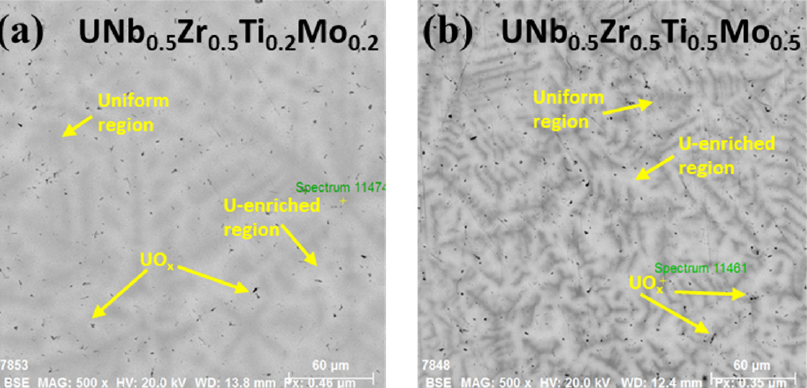
Figure 11. Microstructures of the ( a ) UNb 0.5 Zr 0.5 Ti 0.2 Mo 0.2 and ( b ) UNb 0.5 Zr 0.5 Ti 0.5 Mo 0.5 alloys.